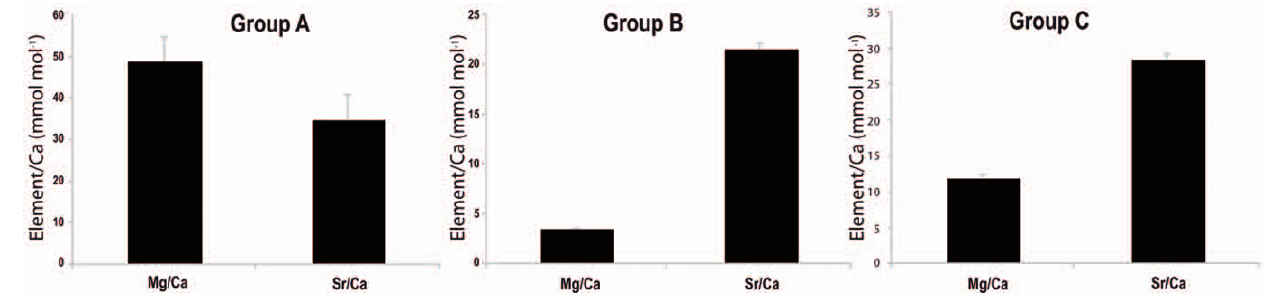
Table 2. Percentage of post-settlers from one of the three groups based on core signatures, in each sampling site.